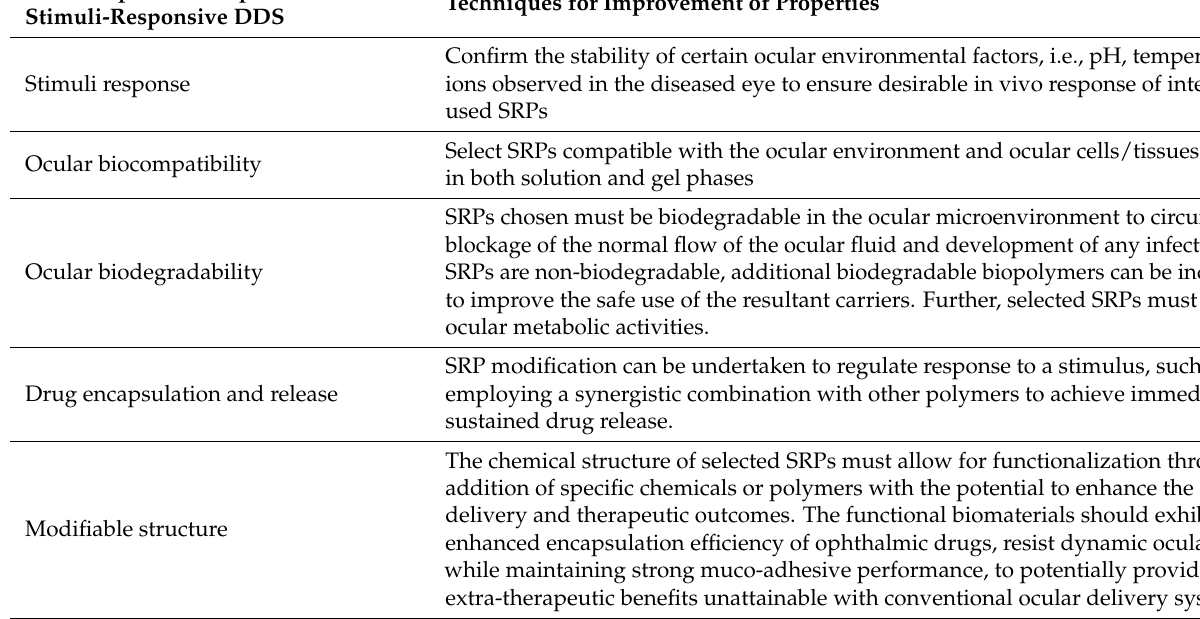
Table 1. Summarized properties ideal for the development of ophthalmic stimuli-responsive DDS using polymers and modes for improvement of stated properties